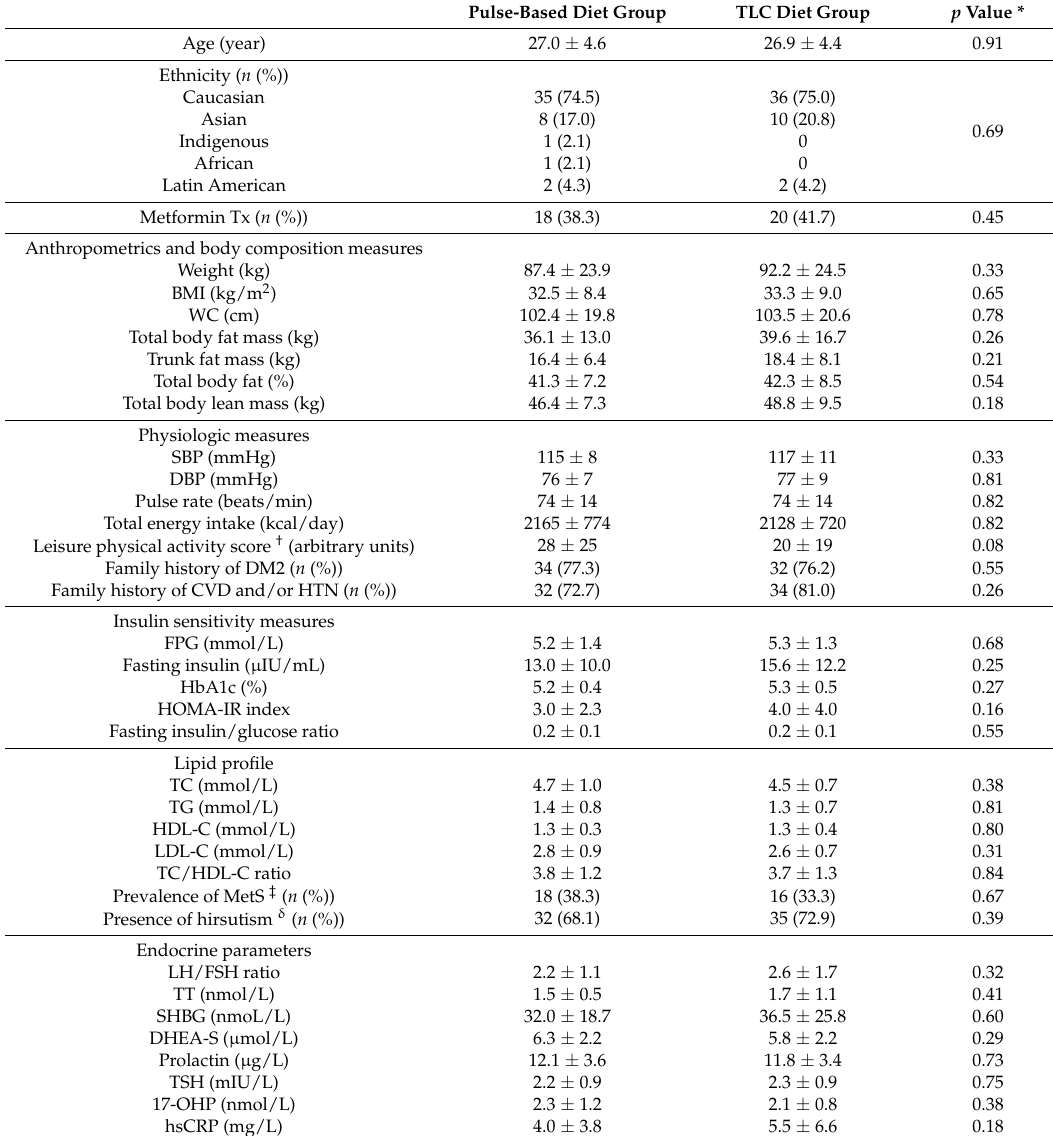
Table 1. Baseline characteristics of women with